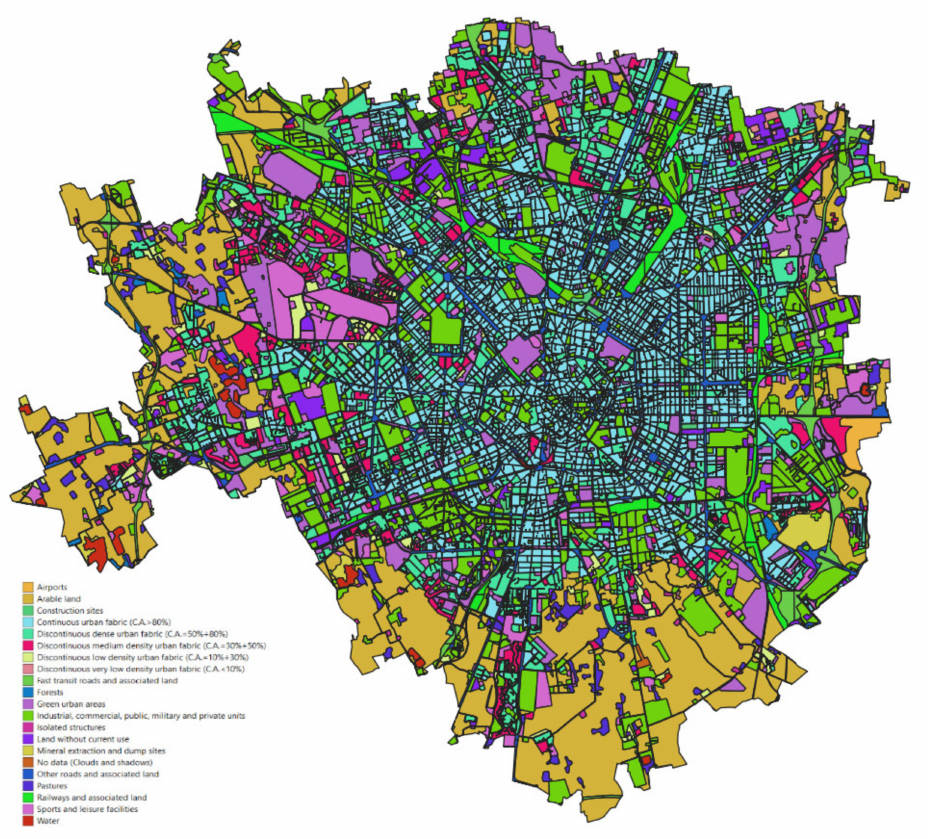
Figure 7. Classification of the Milan area based on the Destinazione d’Uso del Suolo Agricolo e Forestale